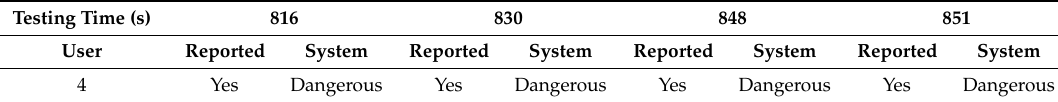
Table 11. Comparison between feedback data and system prediction results for user 4.